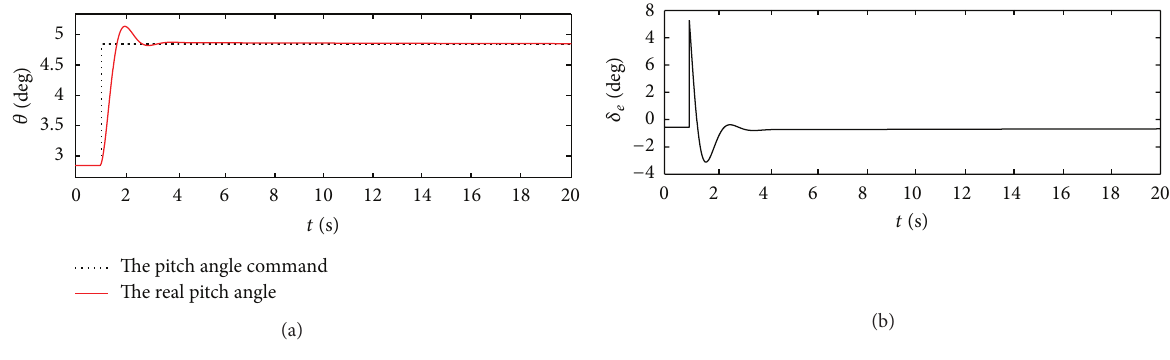
Figure 6: Pitch angle response and elevator deflection angle.